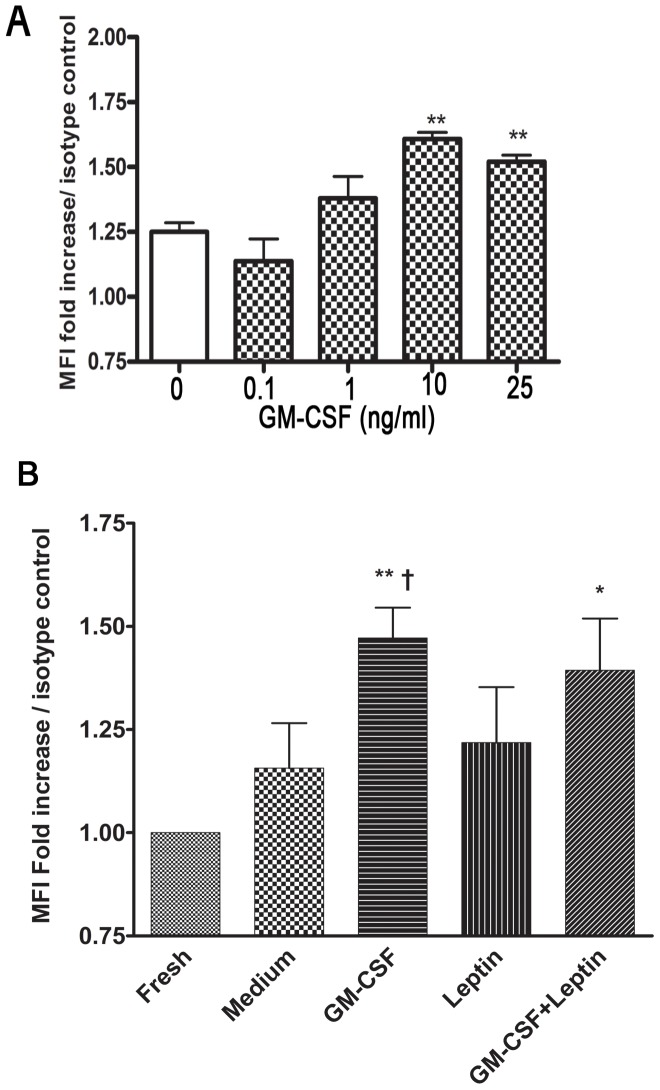
GM-CSF up regulates surface leptin receptor expression in peripheral neutrophils isolated from children.A. Dose response effect of GM-CSF (0.1, 1, 10, 25 ng/ml) on leptin receptor expression on neutrophils from children (n = 3, P<0.01). B. Neutrophils incubated with GM-CSF (10 ng/ml), leptin (10 µg/ml), combination, or alone for 2 h were analyzed by FACS with mouse anti-human leptin mAb and mouse IgG2a isotype-matched control Ab. Mean fluorescence intensity (MFI) of anti-leptin receptor is plotted as fold increase compared to isotype control. (n = 7, data shown as mean ± SD) **p<0.01, *p<0.05 compared to freshly isolated group, one-way ANOVA; †p<0.05 compared to medium control, unpaired t test.